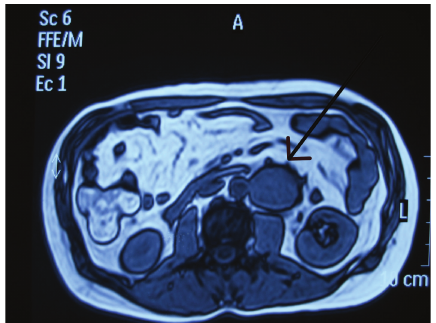
Figure 1: Abdominal MRI imaging depicting the lesion.